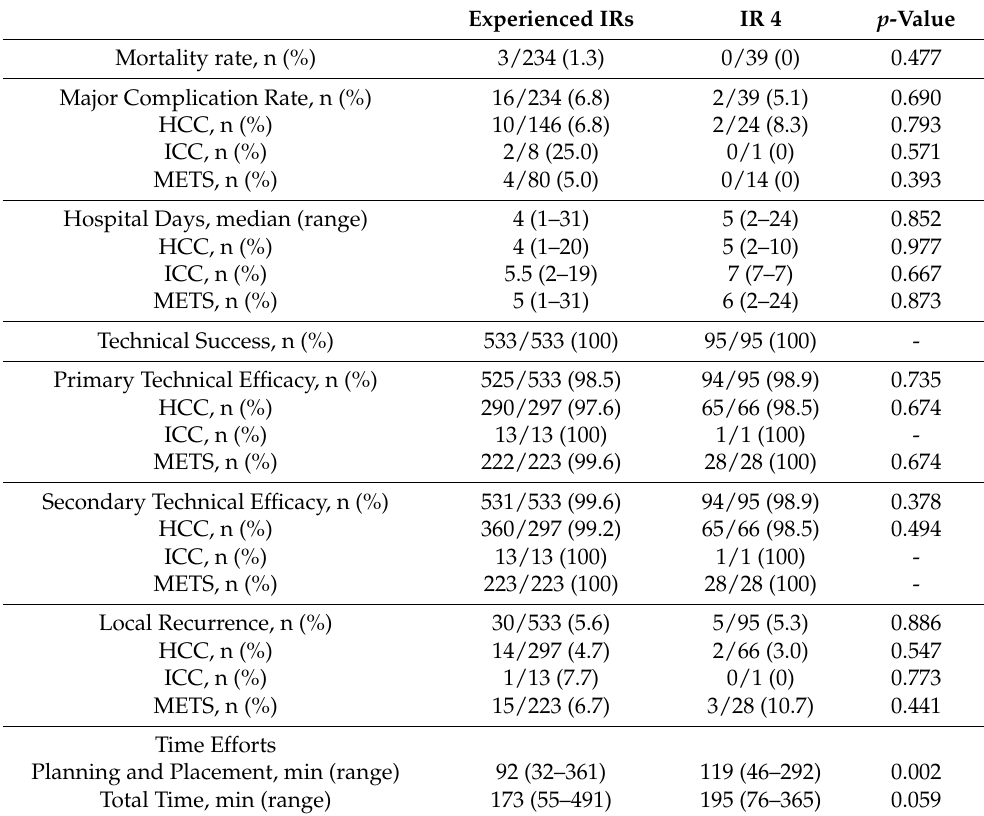
Table 3. Ablation Results grouped by experienced IRs (IR1–IR3) and novice IR (IR